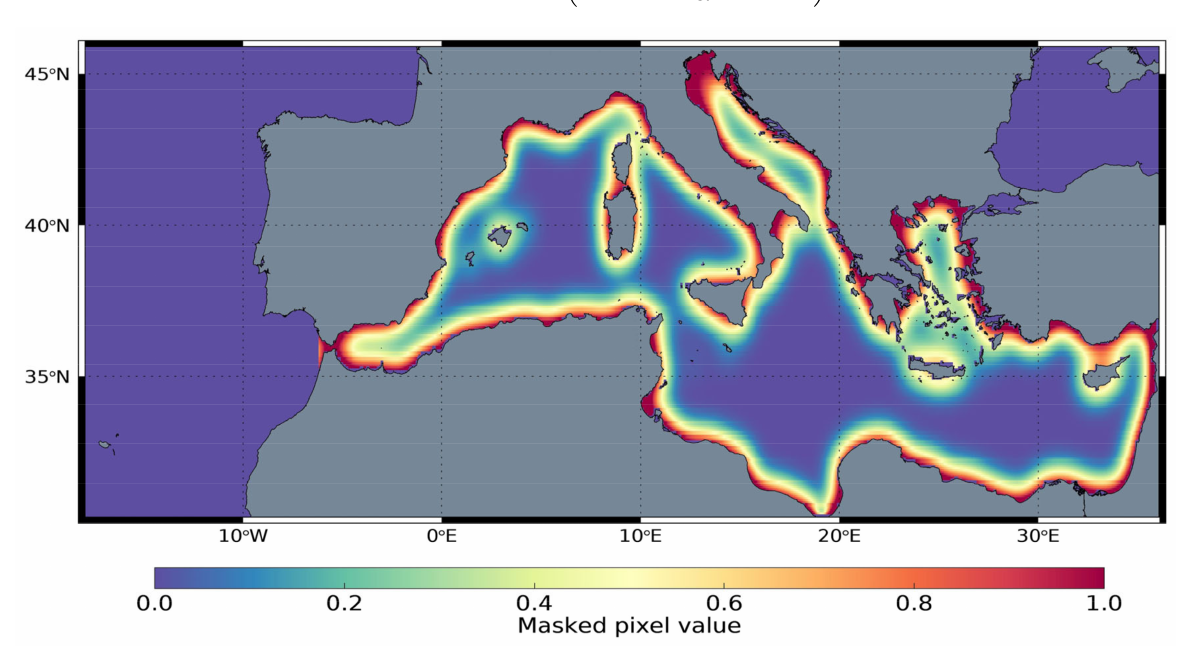
Figure 3. Map of the mask used to build the background from the blending of in situ monthly climatology and weekly CMEMS L4